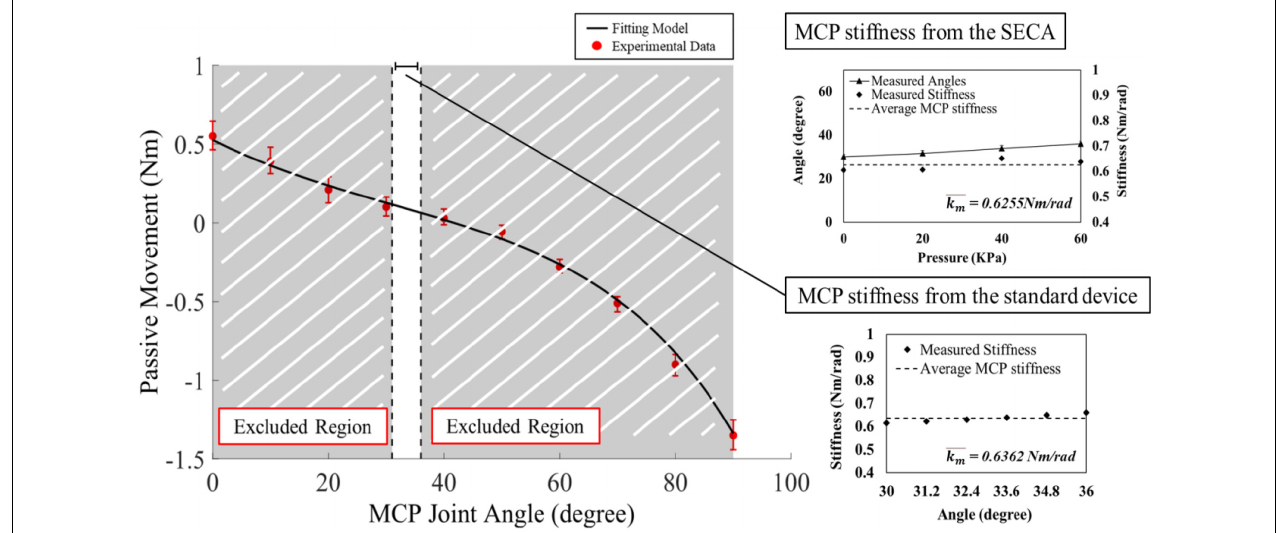
FIGURE 4 | Examples of the experimental data and model fitting results for subject S3 with chronic stroke with MAS = 3. The torque and angle of the MCP joint in S3 is collected from the ROM of 0 ◦ to 90 ◦ for model fitting. Results of MCP joint stiffness in S3 are presented by two different estimation methods. Using the SECA, pressure is increased by 20 kPa until the angle reaches the upper limit. Using the standard device, six joint angles are selected by portion in the angle range for estimation of MCP joint stiffness. Error bar presents the different between the maximum and minimum measured stiffness values. Final joint stiffness is taken by the average of all measured